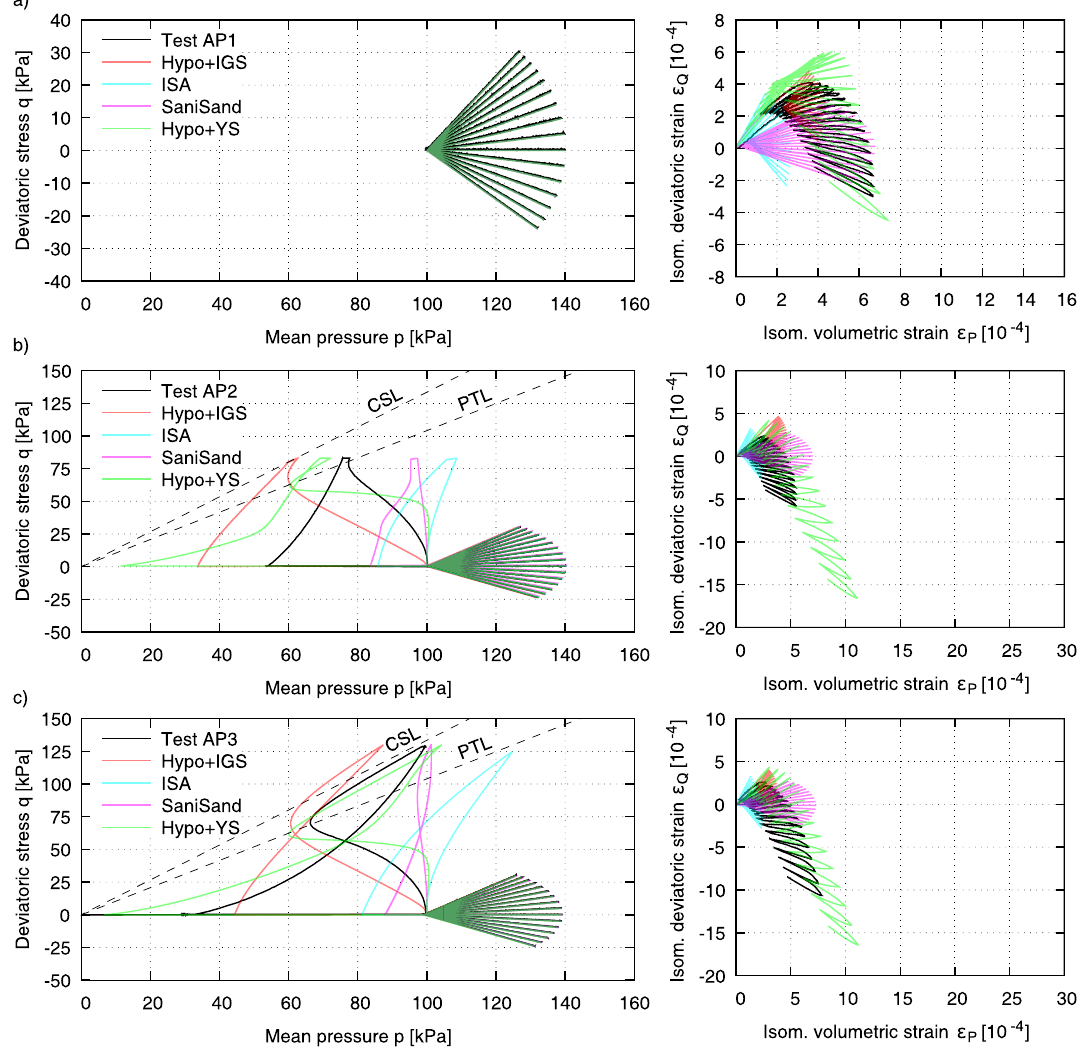
Figure 10. Simulations of tests AP1, AP2 (small undrained preshearing) and AP3 (large undrained preshearing in triaxial